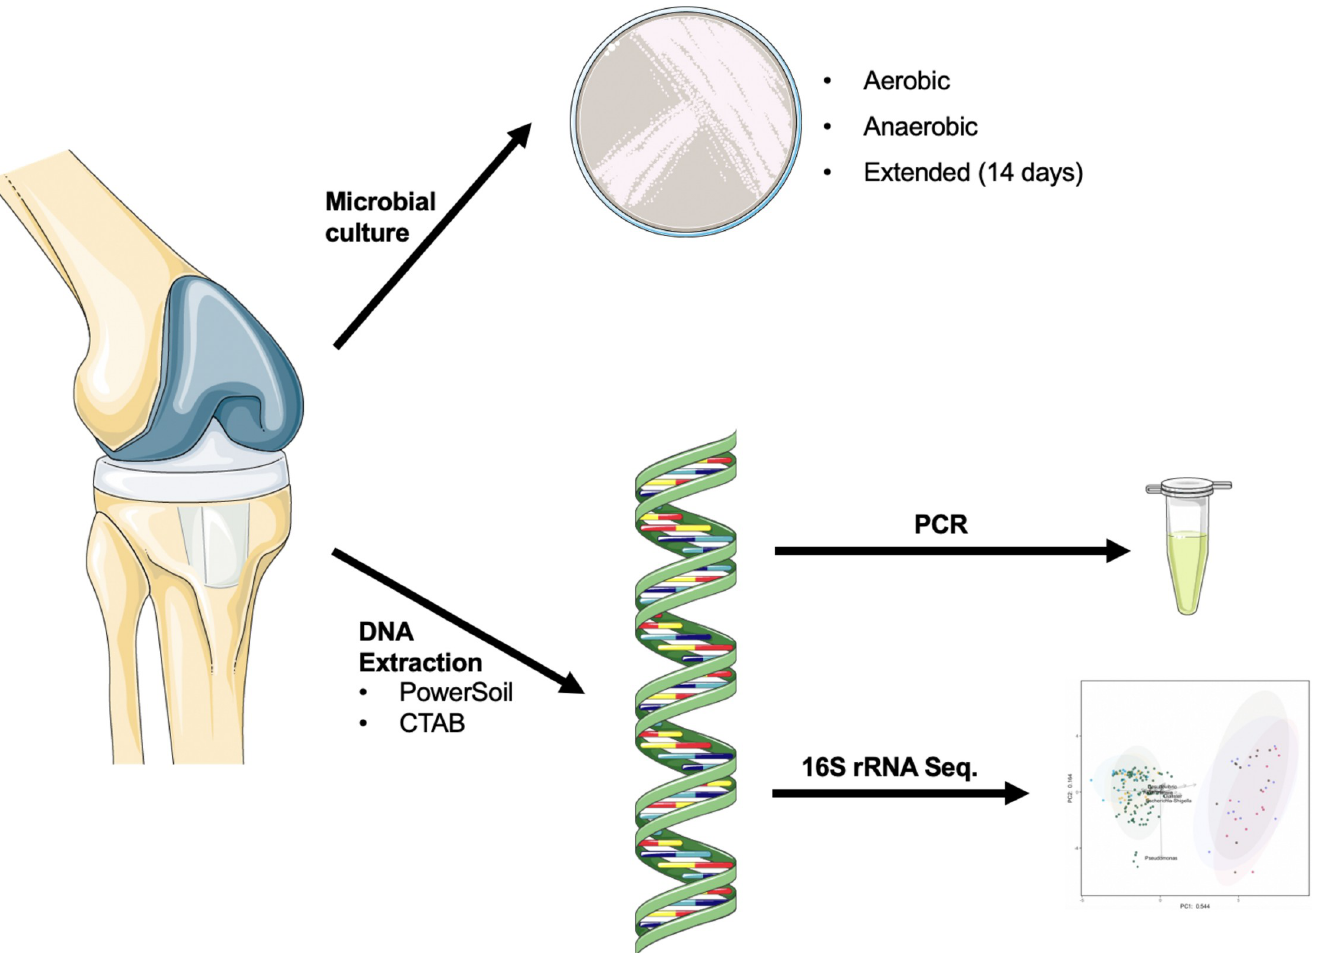
Fig 1. Overview of study design. Samples were collected during revision of presumed aseptic hip and knee implants. Aerobic, anaerobic, and extended microbiological culture was used to diagnosis PJI. DNA was extracted for use in amplification and sequencing of the V4 hypervariable region of the 16S rRNA gene, and for PCR targeted to C . acnes and S . aureus . Graphics were obtained from Servier Medical Art by Servier and used under a Creative Commons Attribution 3.0 Unported License.